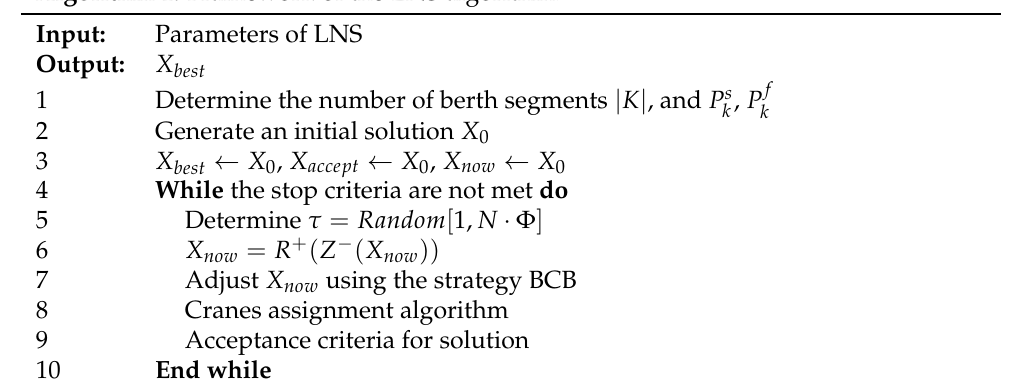
Algorithm 1: Framework of the LNS algorithm.